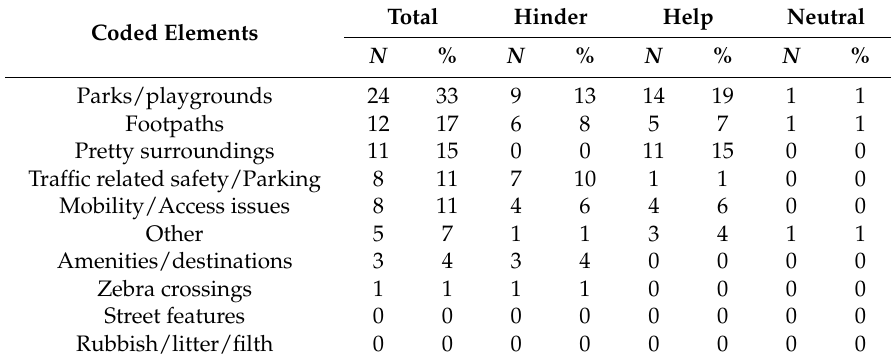
Table 2. The barriers and facilitators coded by citizen scientists at the Discuss session, ranked by total frequency, that hinder or help physical activity (walking) and access, January